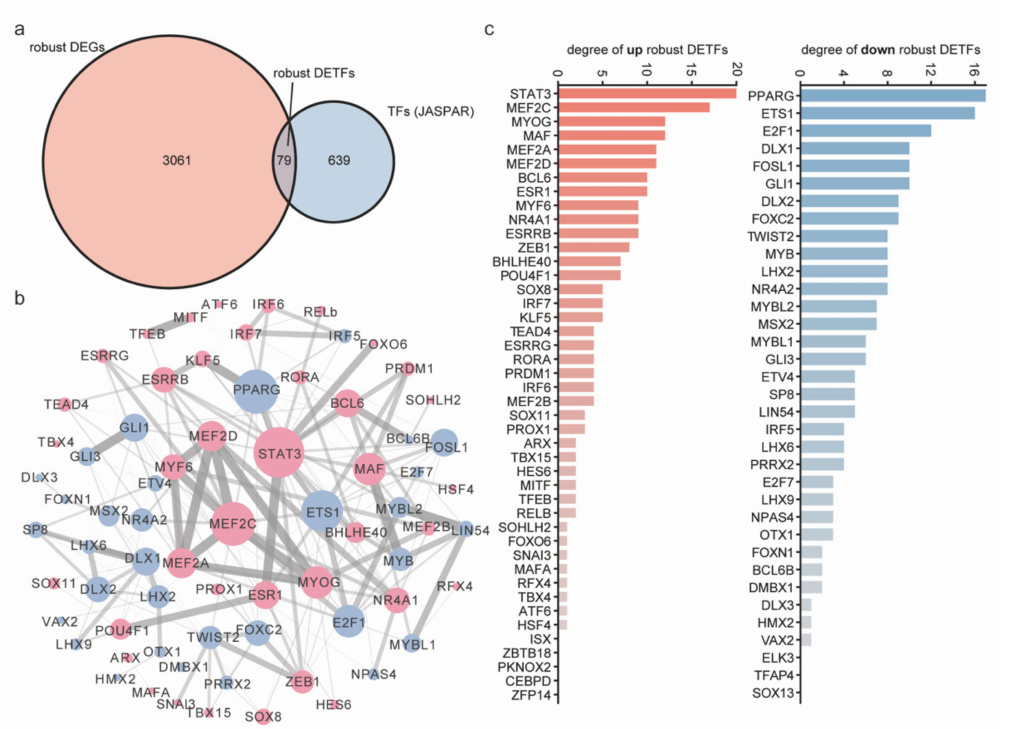
Figure 6. PPI network analysis of robust DETFs. ( a ) The overlap between robust DEGs and vertebrate TFs from the JASPAR database yields robust DETFs. ( b ) PPI network for robust DETFs. Thicker lines with heavier black represent stronger protein interactions. Red represents upregulation, and blue represents downregulation. ( c ) Lists of up- and downregulated robust DETFs sorted by PPI degree.